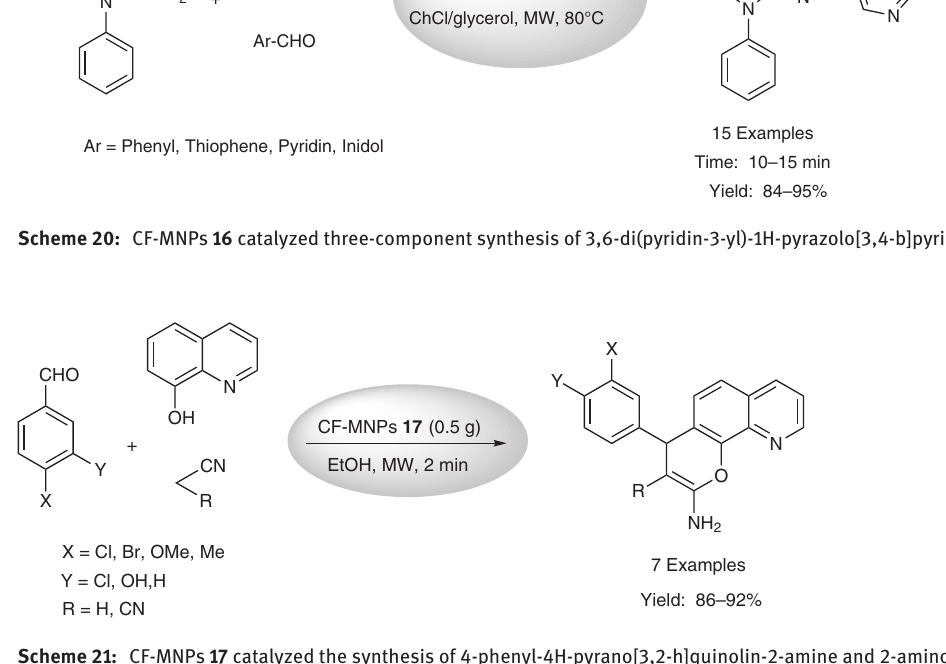
quinoline-3-carbonitrile